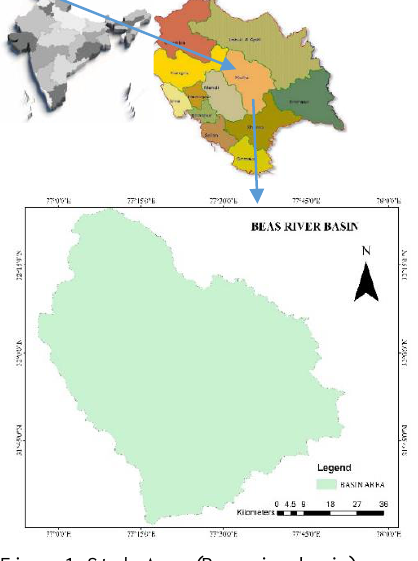
Figure 1. Study Area (Beas river